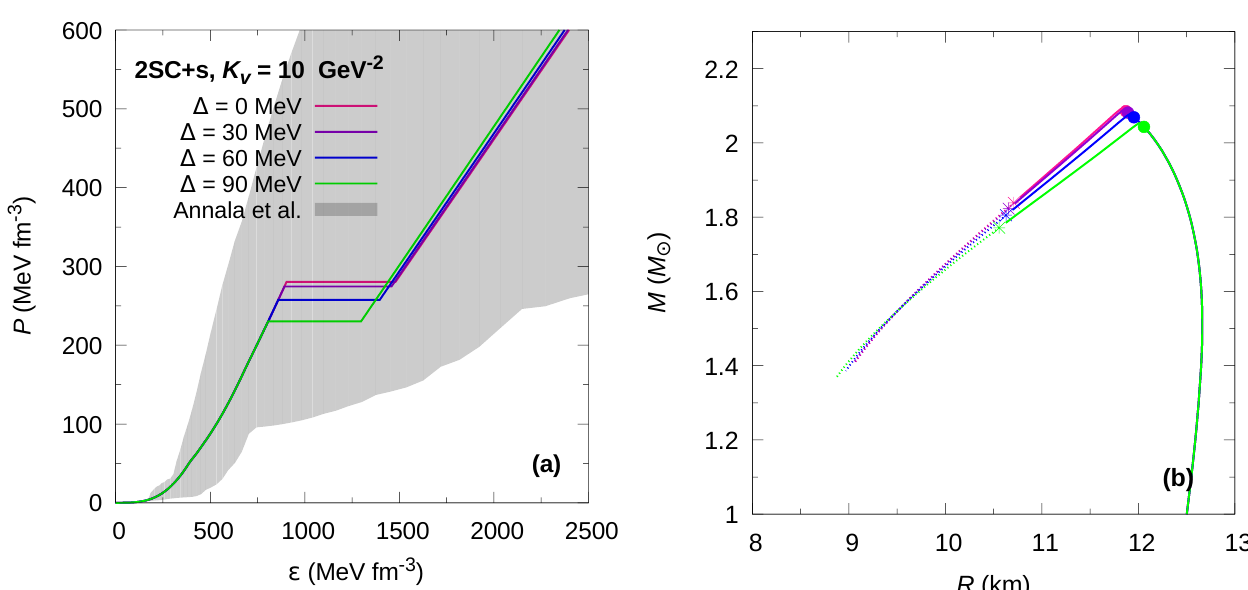
Figure 3. Hybrid EoS (panel ( a )) and mass-radius relationship (panel ( b )) for the 2SC+s phase at fixed gap value of K v = 10 GeV − 2 , for different values of the ∆ parameter. In panel ( a ), the grey region shows the constraints presented in [42]. The solid dots in panel ( b ) indicate the appearance of the color superconducting phase, just before the maximum mass peak. For rapid conversions, the stellar configurations to the left of each maximum mass are unstable and the existence of HSs is only marginal. For slow conversions, an extended stability branch exists. The stable configurations are shown by continuous lines. The terminal configurations are marked with asterisks.